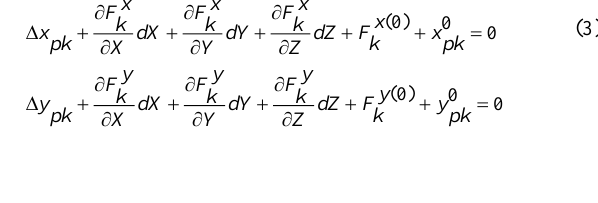
Fig. 6. The flowchart of the dense matching